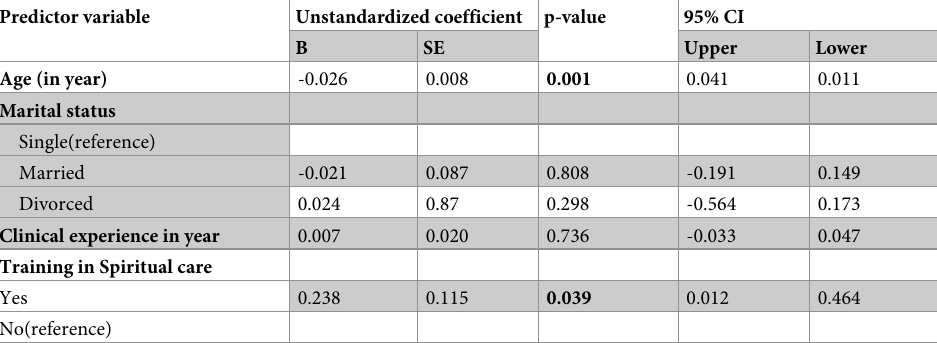
Table 4. Results of multivariable linear regression among nurses at selected public hospitals in southwest Ethiopia in 2021. Predictor